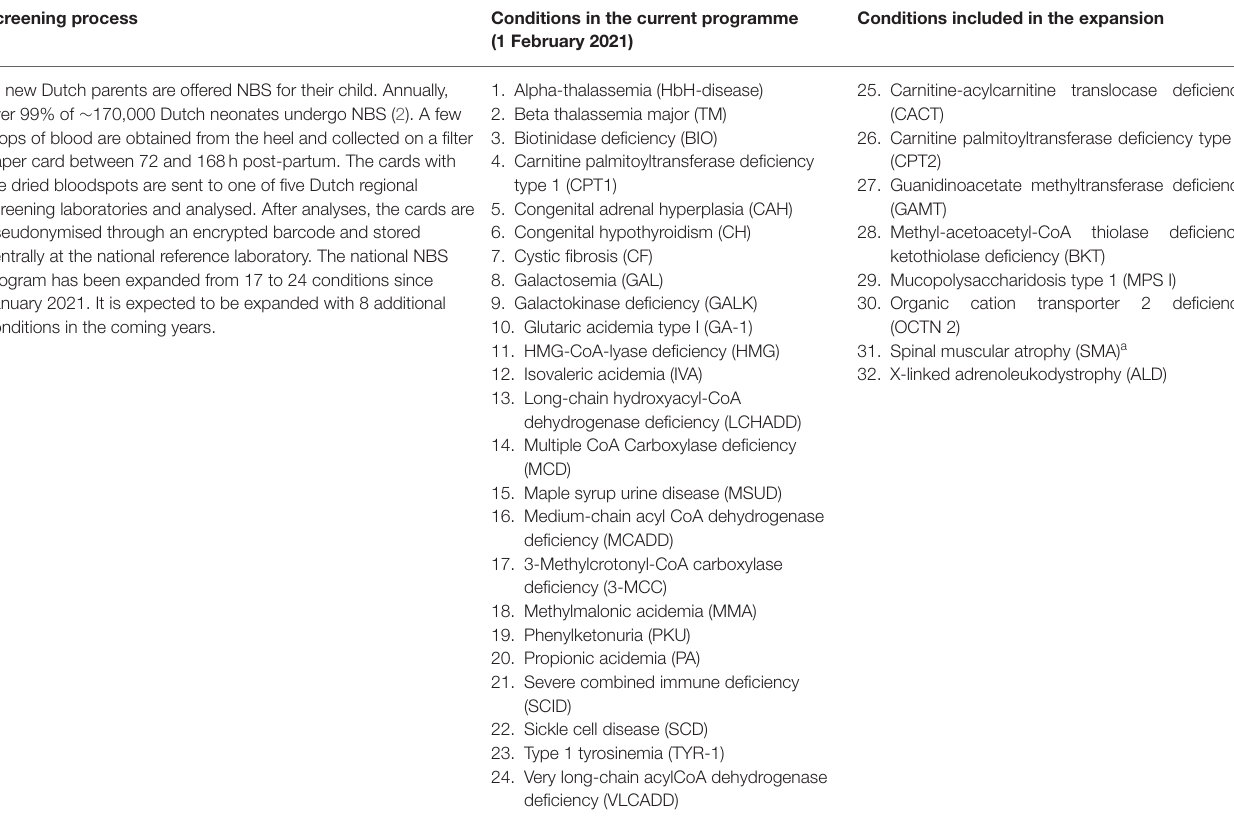
TABLE 1 | Neonatal screening programme in the Netherlands summarised. Screening process Conditions in the current programme